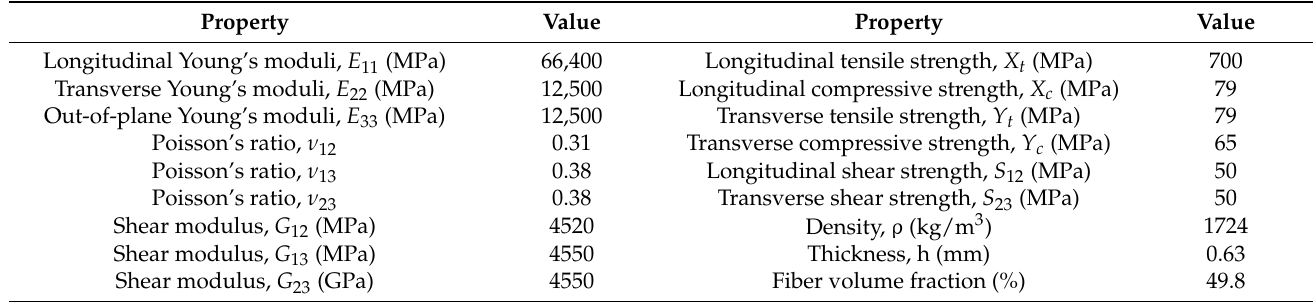
Table 3. The ply properties of GFRP composite being used [11,56].